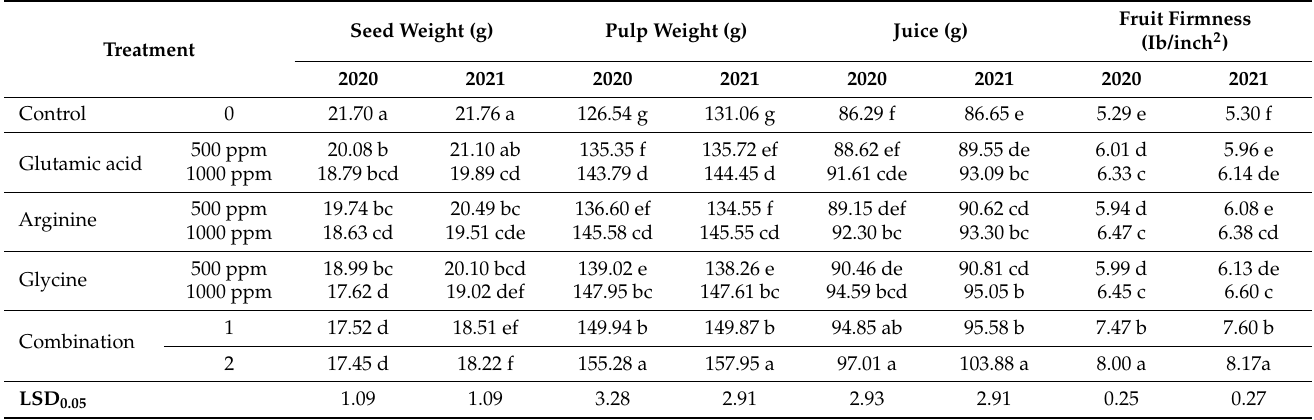
Table 4. The influence of glutamic acid, arginine and glycine amino acids on seed weight, pulp weight, fruit juice content, and fruit firmness of guava during the 2020 and 2021